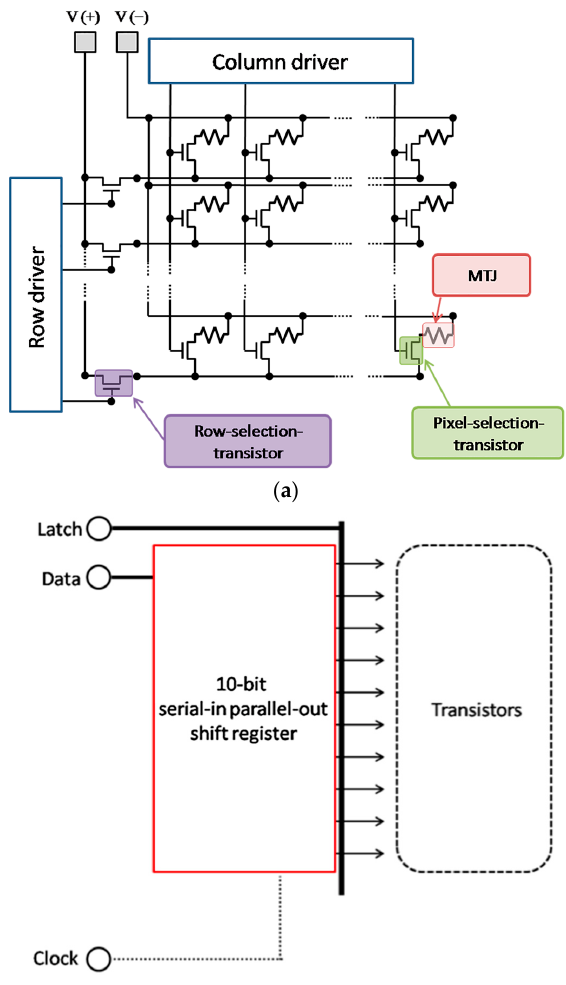
Figure 2. ( a ) Schematic illustration of the circuit diagram for the spin-SLM; ( b ) Schematic illustration of the 10-bit shift register. MTJ: magnetic tunnel junction.